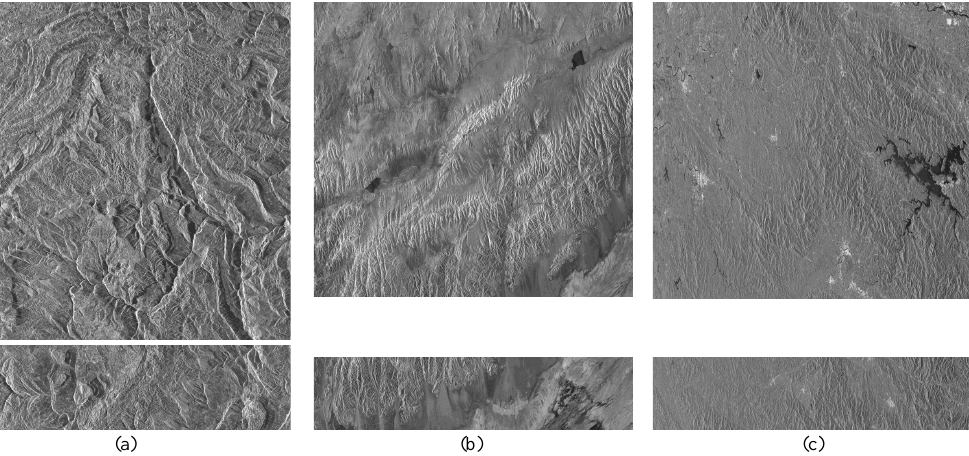
Figure 5. Split train and test data sets for Guiyang, Geermu and Huangshan datasets, respectively. Here, 80% of the images along the azimuth direction are selected for train sets and 20% are selected for test sets. ( a ) is the SAR imagery from Guiyang datasets measuring 8130 × 5796 pixels. ( b ) is the SAR imagery from Geermu datasets measuring 6554 × 4800 pixels. ( c ) is the SAR imagery from Huangshan datasets measuring 6554 × 4800